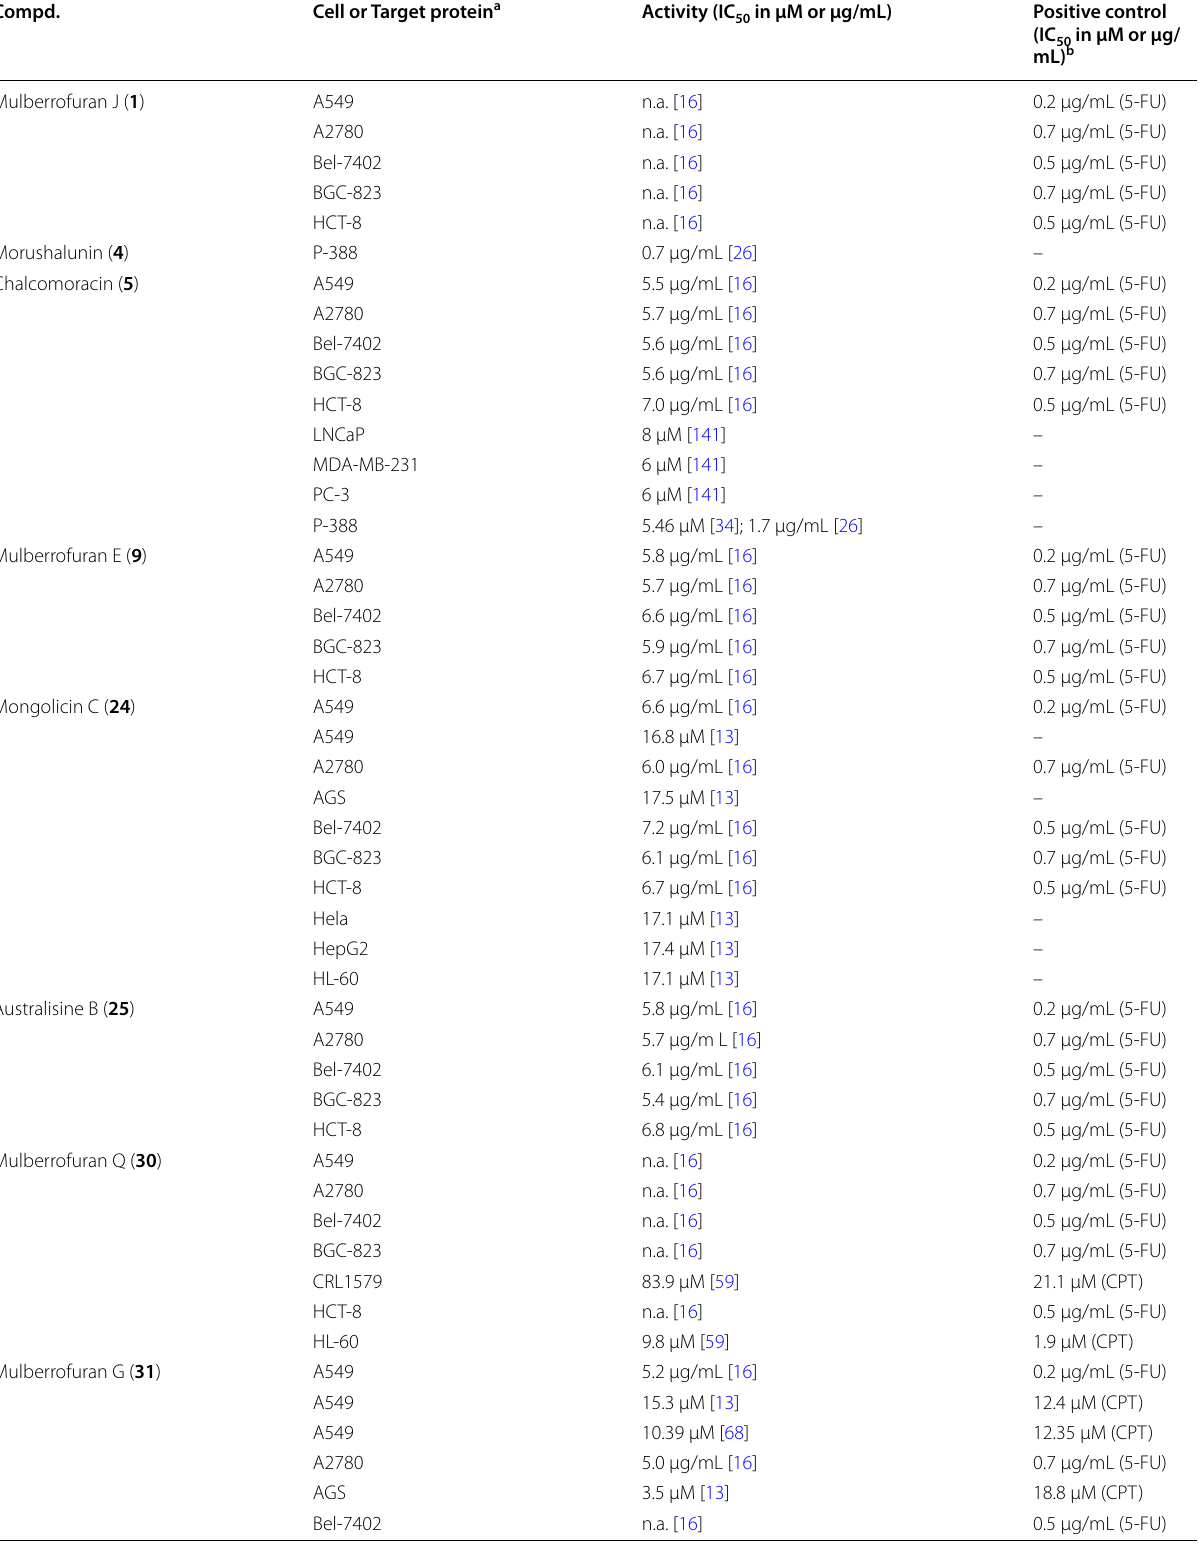
Table 3 Antineoplastic activities of MDAAs against tumor cell lines or target proteins